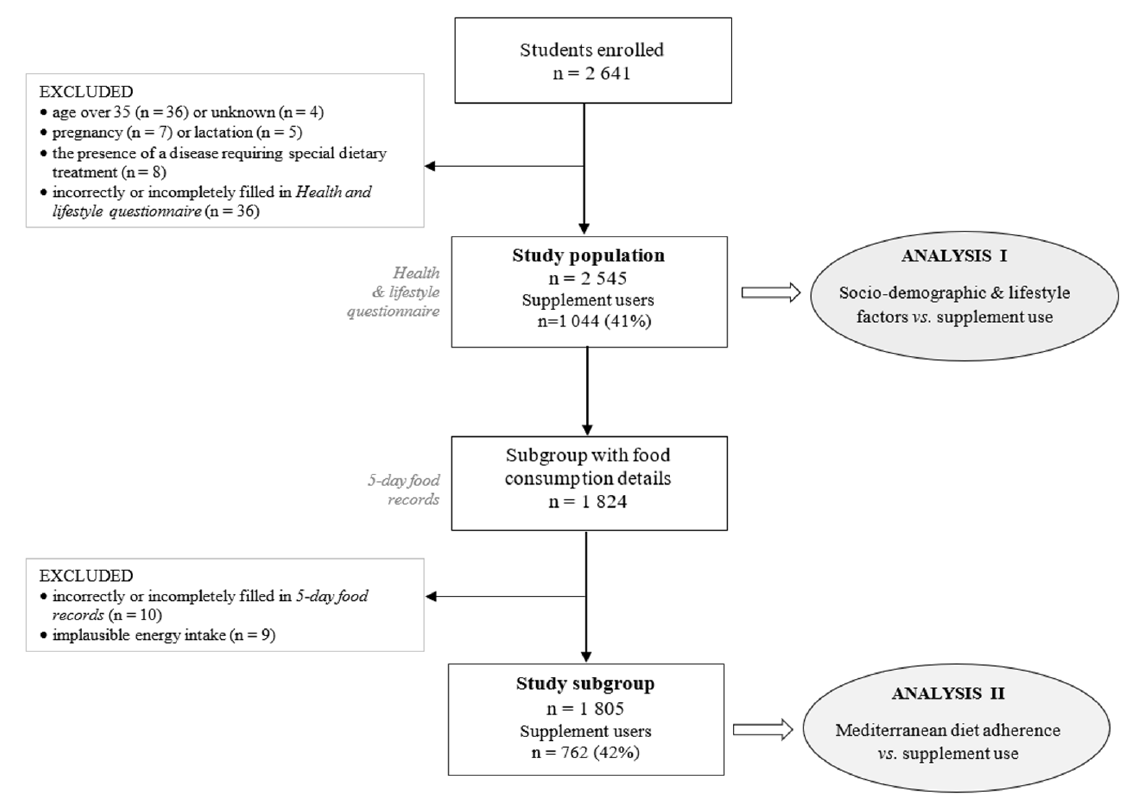
Figure 1. Study population flow chart.